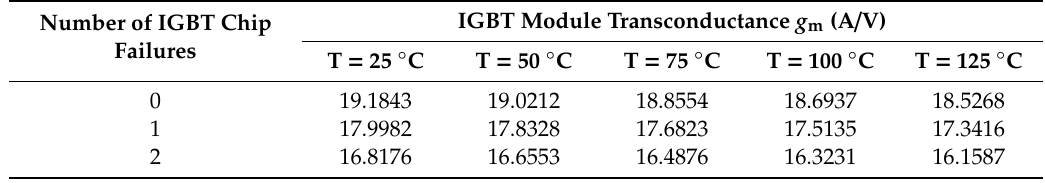
Table 4. Transconductance of IGBT modules under di ff erent temperatures and healthy